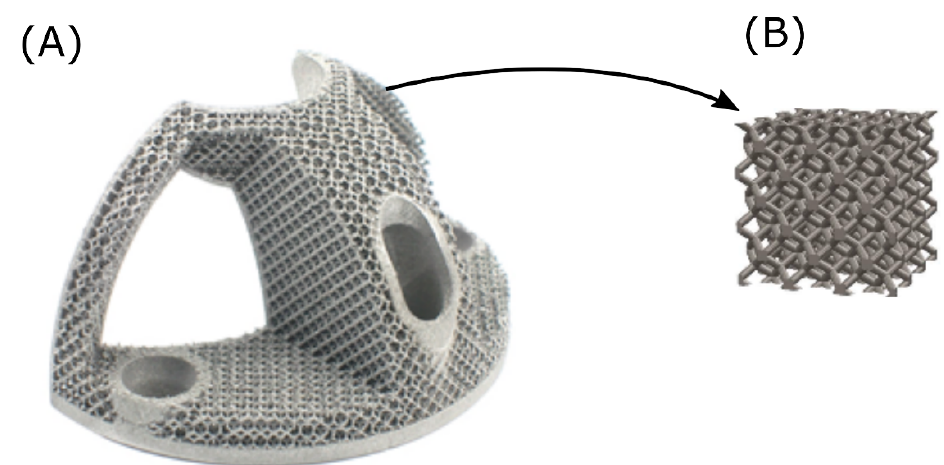
Figure 1. ( A ) Acetabulum metal augments implant with rhombic dodecahedron porous structure surface and ( B ) rhombic dodecahedron cubical element [37].